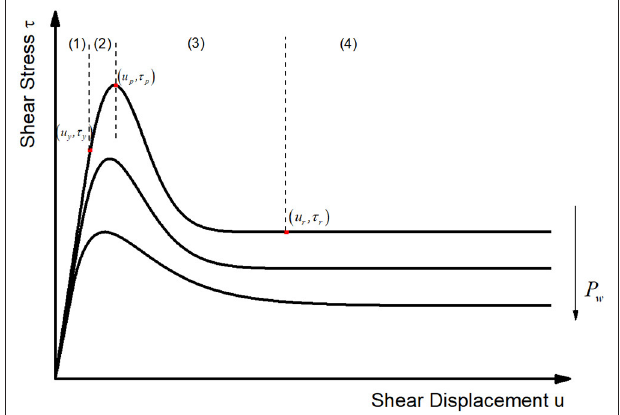
FIGURE 4 | Ideal shear stress-stress displacement